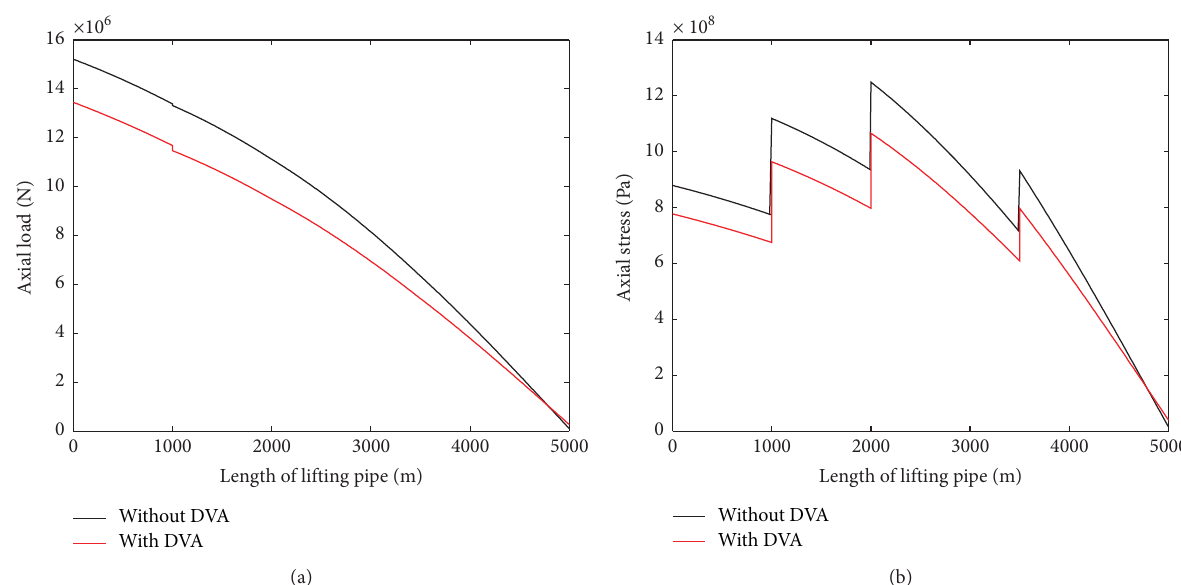
Figure 16: Total axial load and stress with/without DVA. (a) Axial load. (b) Axial